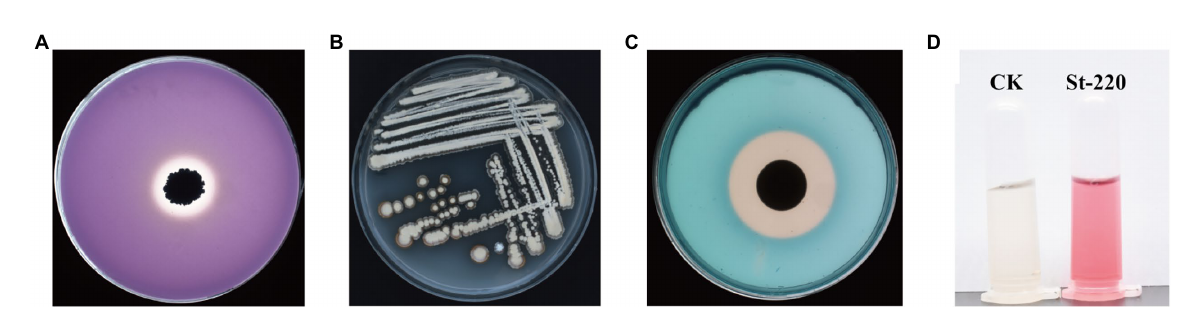
FIGURE 3 Evaluation of strain St-220 for key traits related to direct plant growth-promotion. (A) Qualitative phosphate solubilization assay. (B) Biological nitrogen fixation activity assay. (C) Siderophores qualitative production assay. (D) Production of indole acetic acid activity